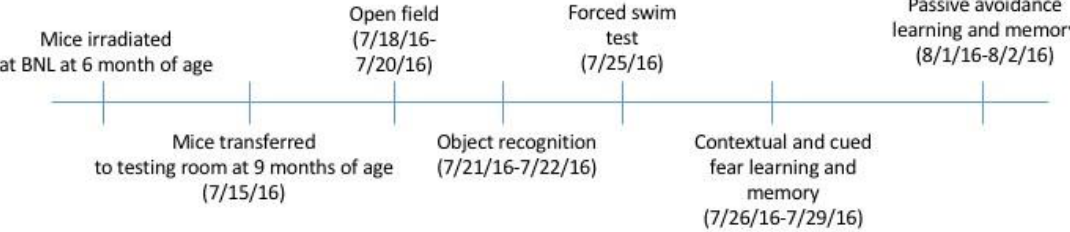
intervals between the distinct tests. The first behavioral test was performed three months following irradiation or sham-irradiation. BNL, Brookhaven National